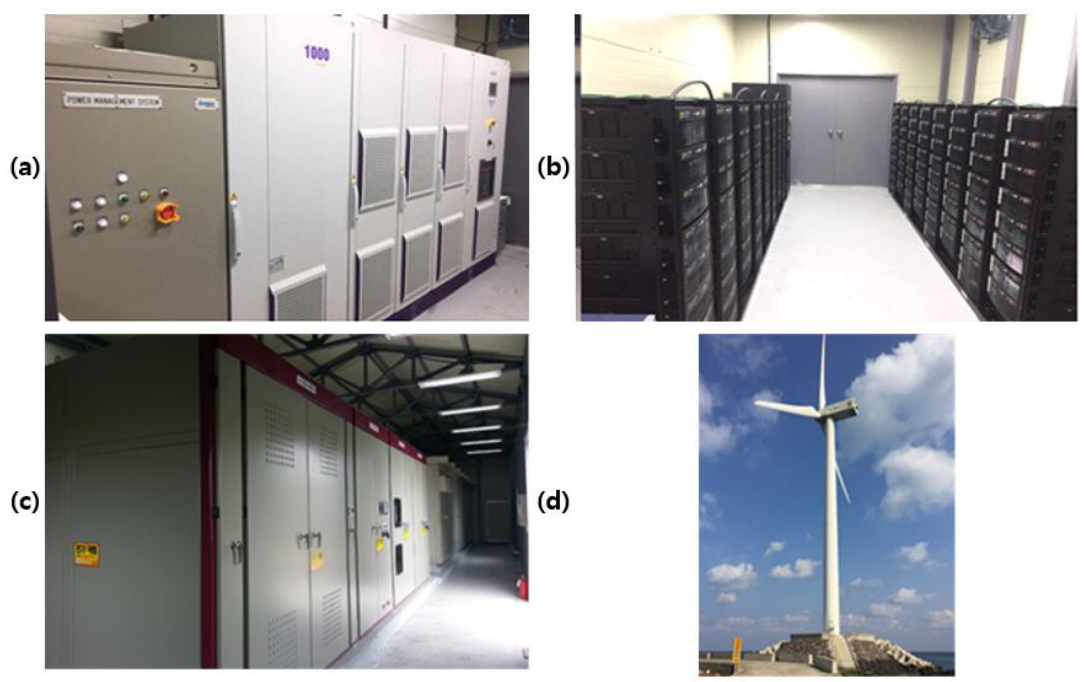
Figure 4. Facilities used in the pilot project: ( a ) 1 MW PCS, ( b ) 0.5 MWh lithium-ion battery, ( c ) switchgear, and ( d ) 3 MW wind turbine.